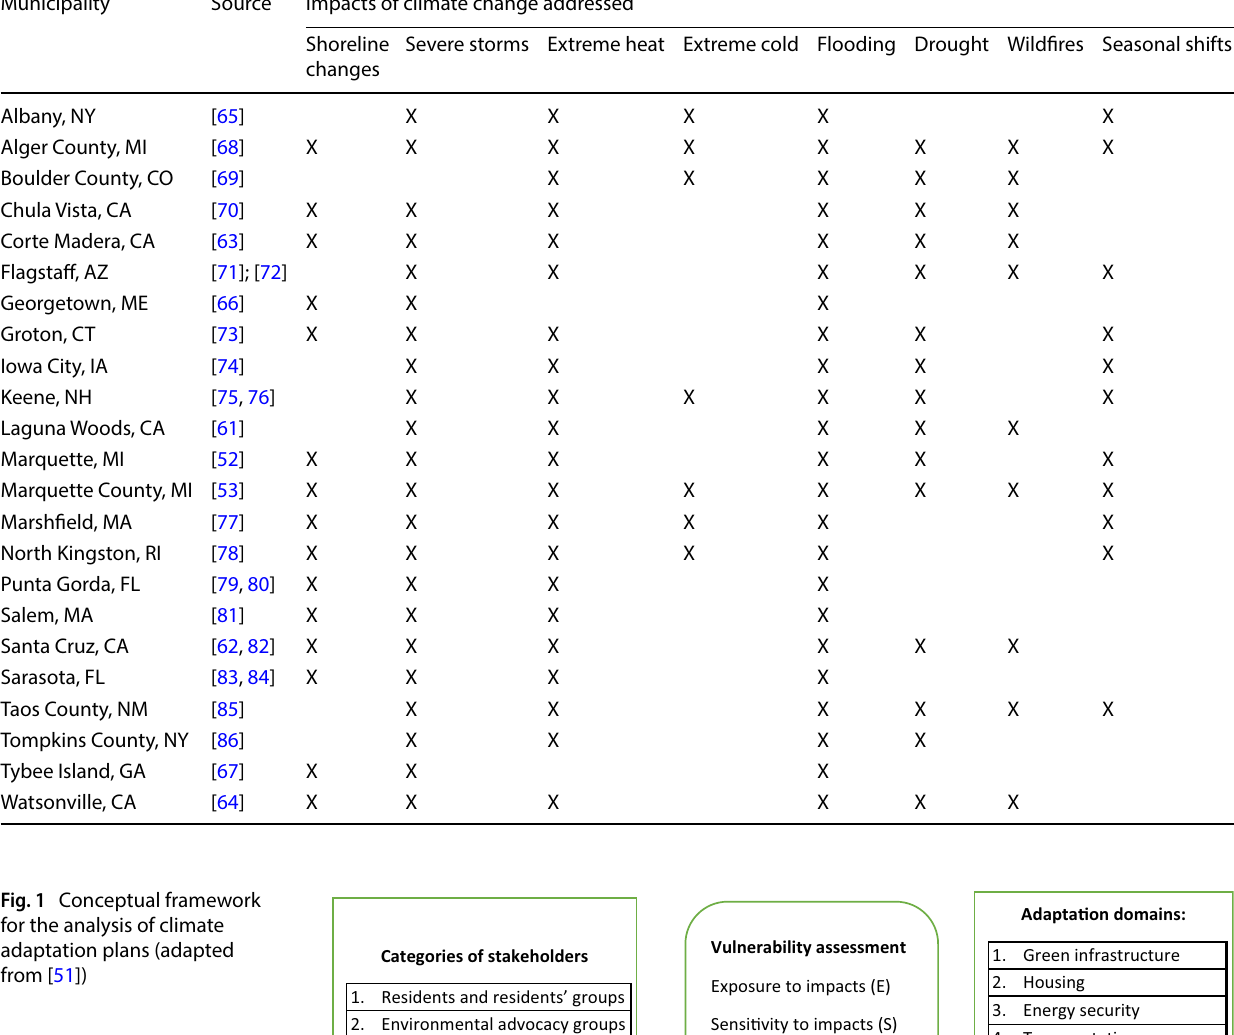
Fig. 1 Conceptual framework for the analysis of climate adaptation plans (adapted from